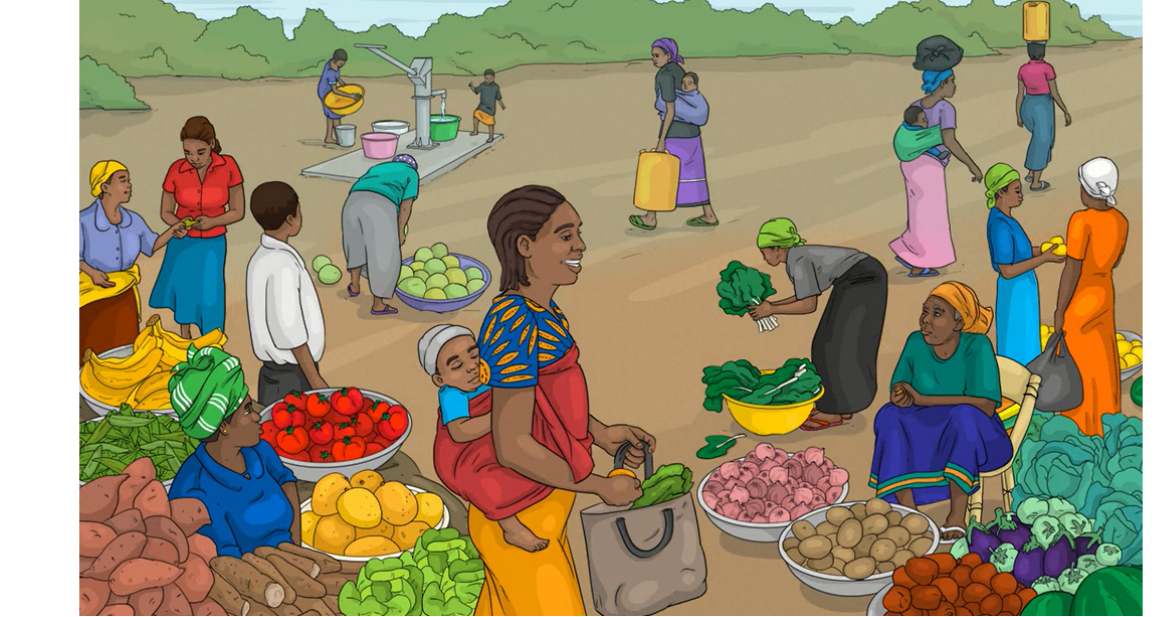
Figure 9. Market after adaptation.